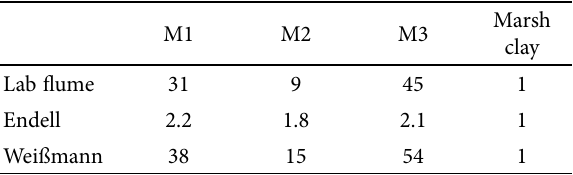
Table 17. Comparison of orders of magnitudes of disintegration tests and laboratory flume M1 M2 M3